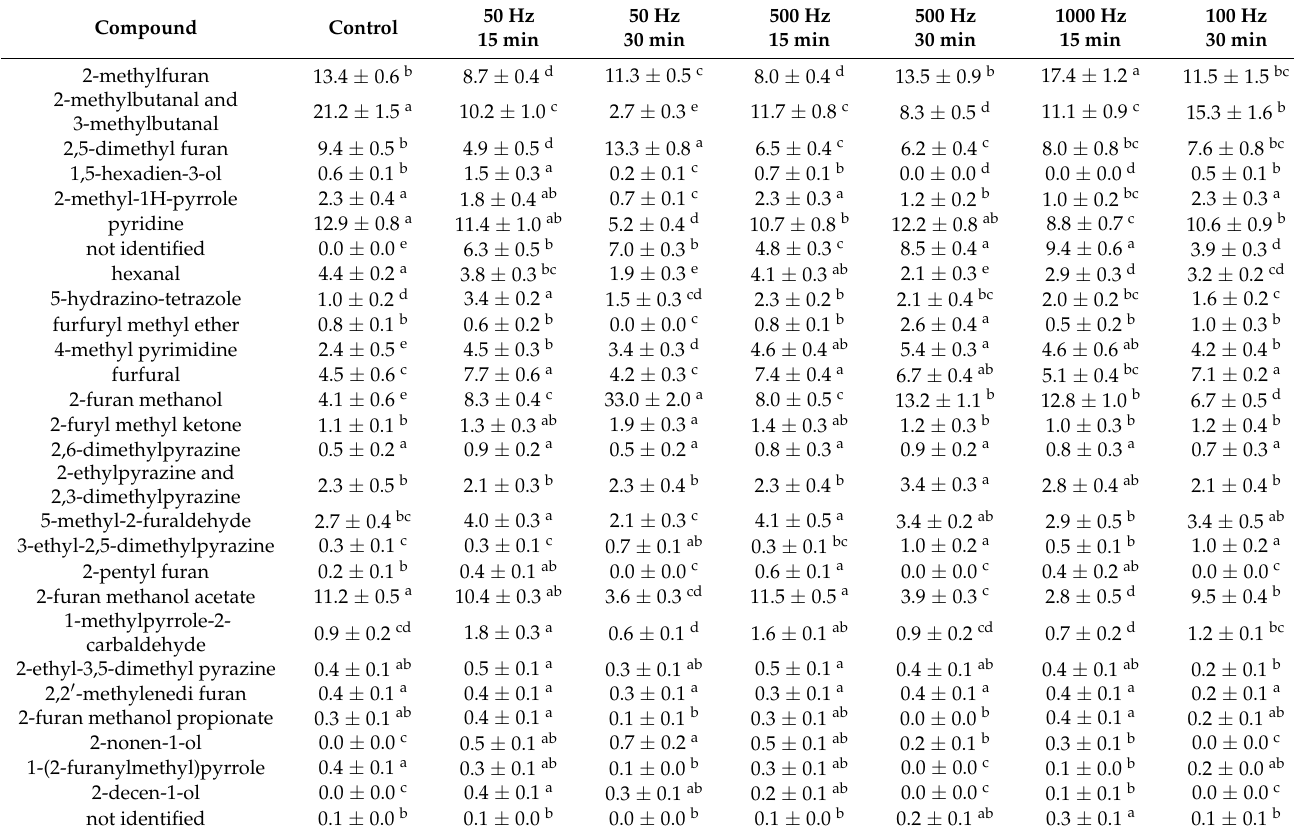
Table 2. The mass fraction of the volatile compounds identified in ready-to-drink coffee in the control and plasma-treated samples. Different letters indicate statistically different